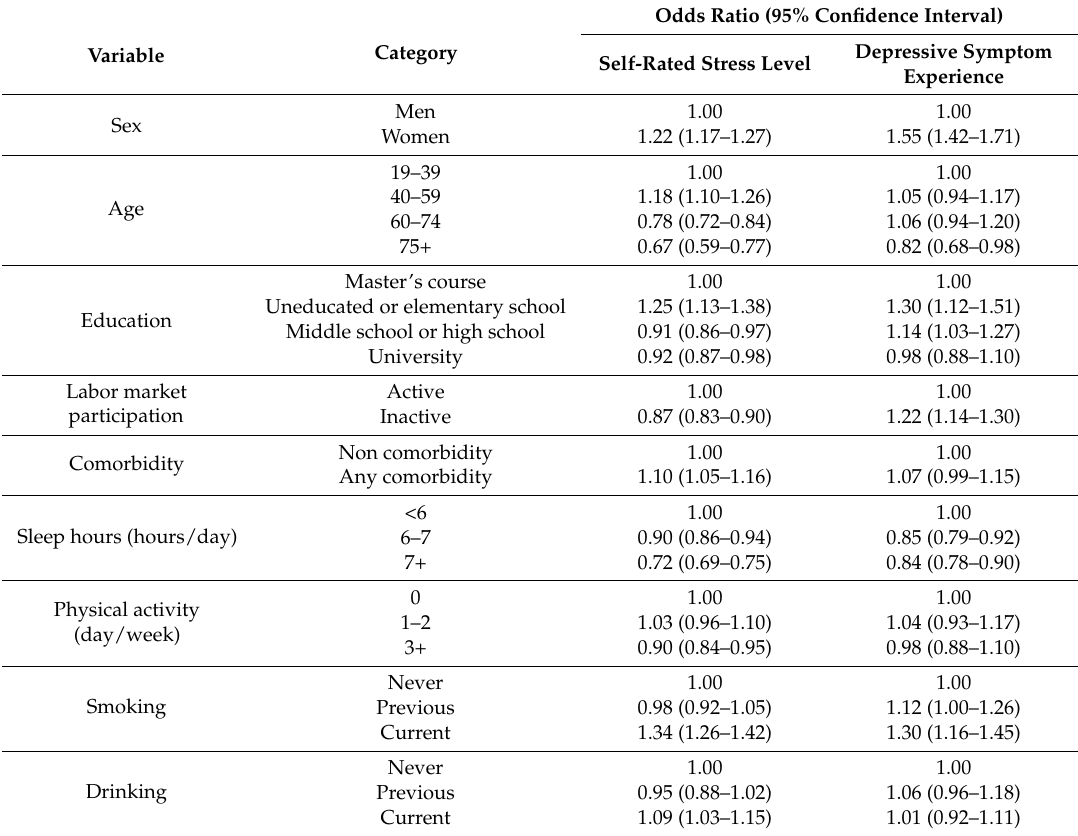
Table 3. Associations between mental health outcomes and demographic